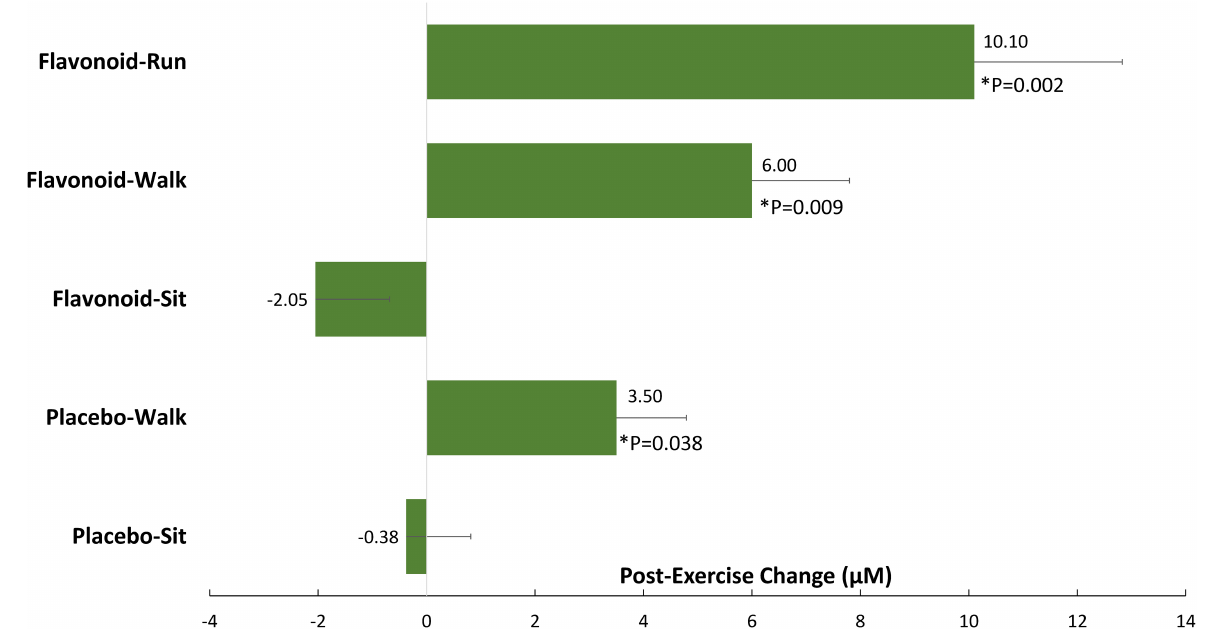
Frontiers in Neuroscience |